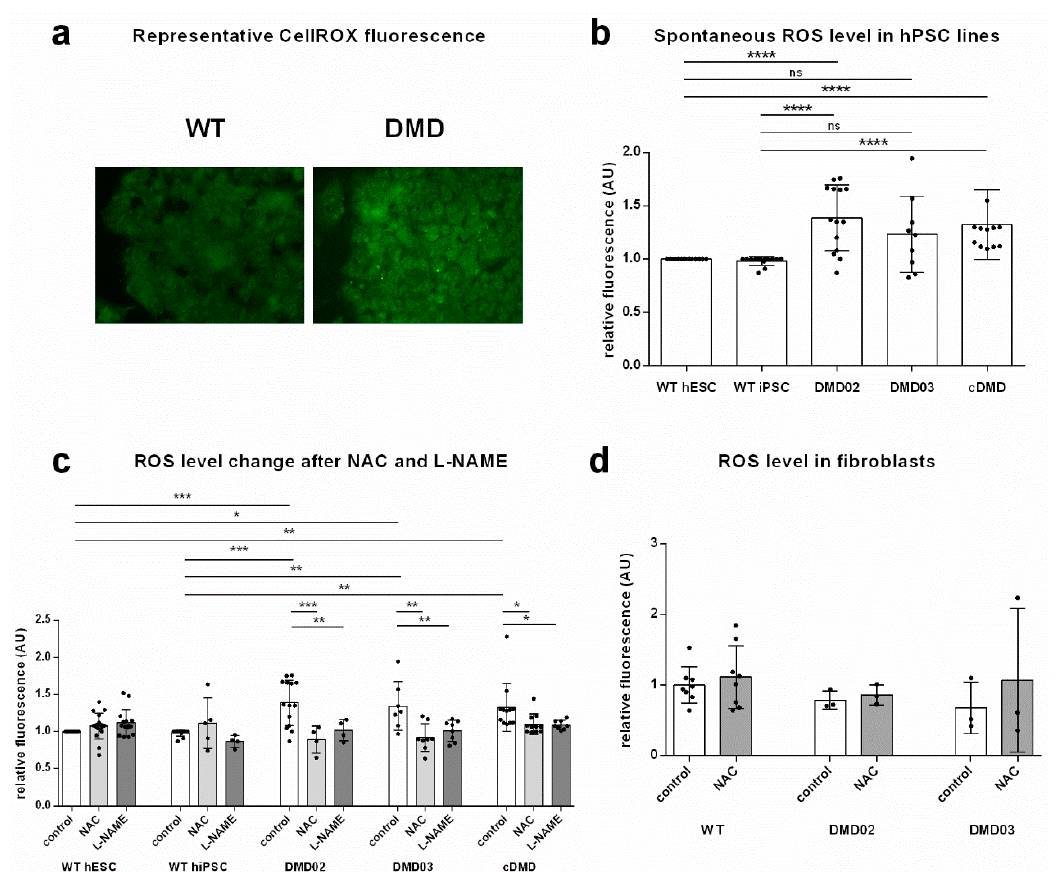
Figure 3. Elevated spontaneous NOS induced ROS release in DMD hPSC. ( a ) Representative example of ROS level in hiPSC line DMD03 compared to WT hESC. Fluorescence intensity per area (Image J) was normalized to WT hESC. ( b ) Spontaneous level of ROS measured by CellROX Green dye fluorescent signal in DMD hPSC lines is elevated compared to the WT hESC. Statistical significance was evaluated by One sample t -test comparing the values to normalized relative control in WT hESC and WT hiPSC (* p < 0.05, ** p < 0.01, *** p < 0.001). Error bars show standard deviation. ( c ) ROS production with ROS scavenger N-acetyl- L -cysteine (NAC) treatment was significantly decreased in all tested DMD hPSC lines but not WT hPSC lines compared to the cells with no treatment. ROS production with NOS inhibitor L -NAME decreased significantly in all DMD hPSC lines. Graph shows change in fluorescent intensity per area expressed as percentual value of untreated controls of corresponding hPSC line. Statistical difference was evaluated by two-way ANOVA comparing the NAC/ L -NAME treated cells to non-treated control cells as well as WT cells compared to DMD cells. ( d ) ROS levels in DMD fibroblasts from both DMD patients used for reprogramming do not differ from three independent WT foreskin fibroblasts from newborn boys at similar passage number. Statistical difference was evaluated by one-way ANOVA. At least 3 biological repetitions were used in each experiment, exact value for each is represented by • in each